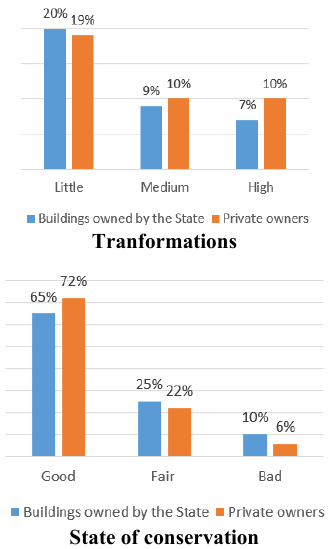
Figure 7. Comparison between state and private owners considering transformations and state of conservation The analysis in Figure 7 reveals the similar condition regarding impacts on private and state owned heritage buildings when proportionally compared to the total of each sector properties (514, private; and 168, state). Little difference is noticed in the state of conservation; however, the situation is always rather unfavourable to the housing stock since it represents a larger number of assets, 75%.